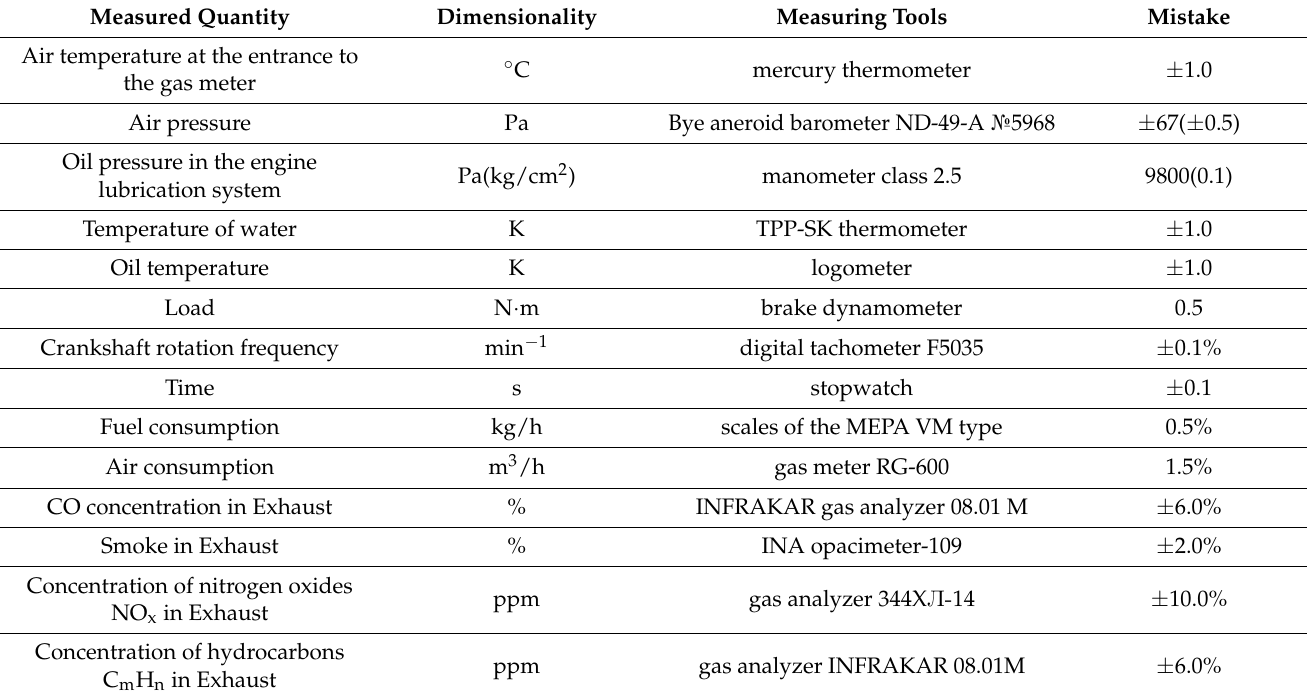
Table 3. Measurement errors of devices and equipment